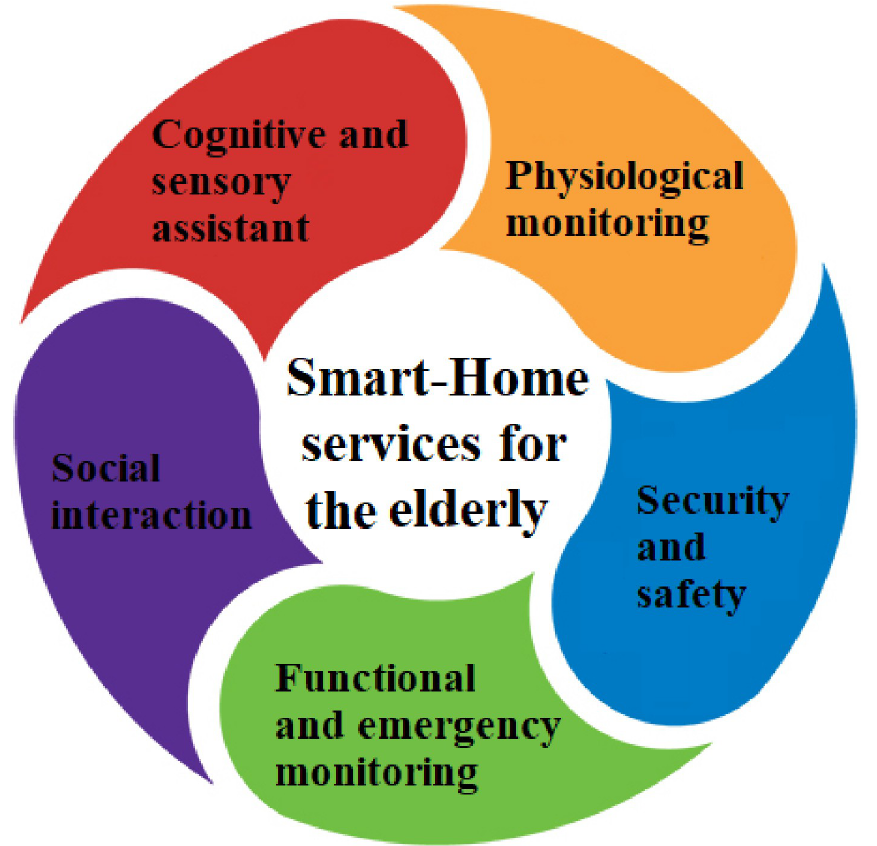
Fig 1. Smart-home technologies and services for the